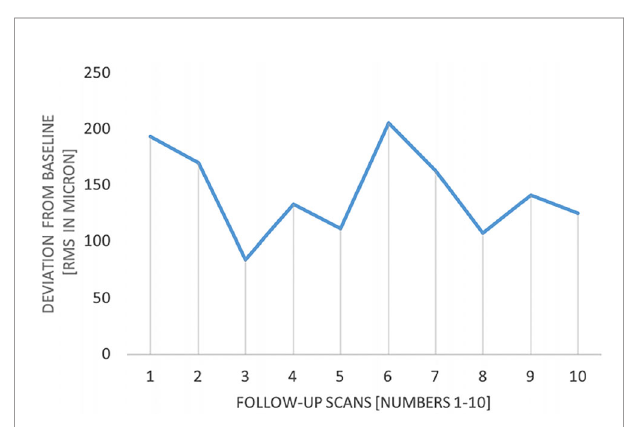
FIGURE 4 | RMS differences between initial reference and follow-up